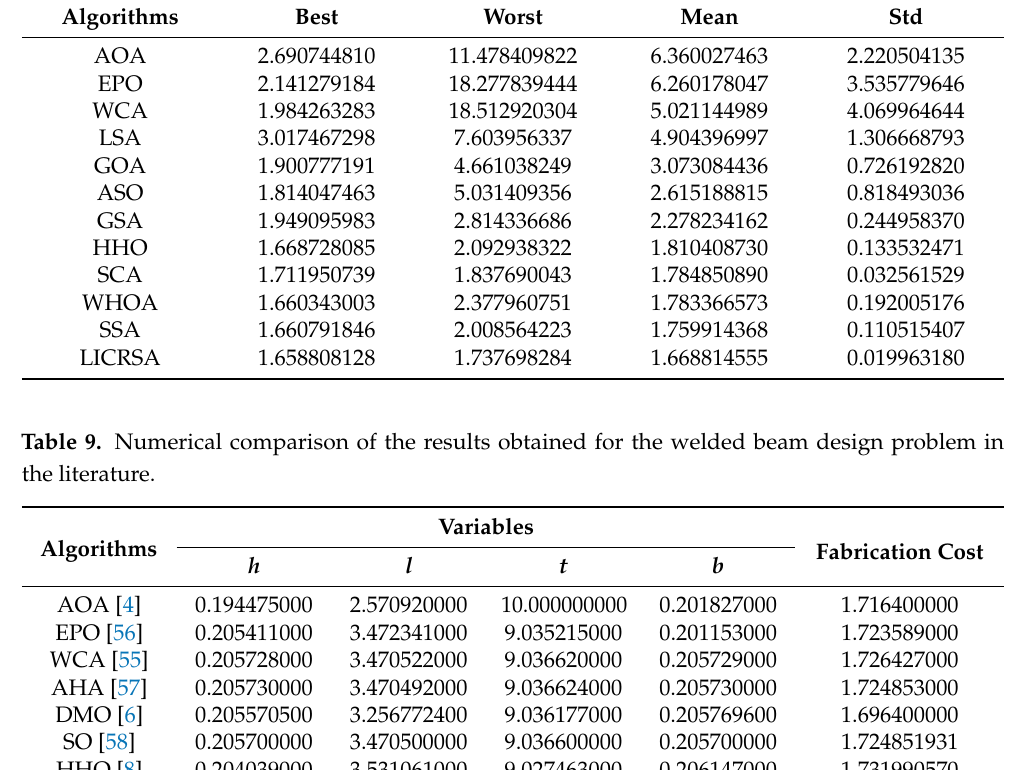
Table 8. Statistics of 20 independent operations of welded beam.